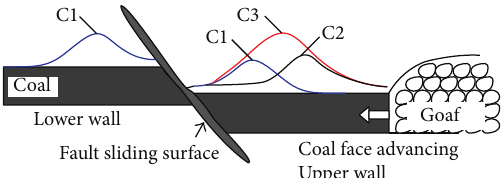
Figure 2: The cross section of a normal fault and abutment distribution: C1 is the preexisting tectonic pressure curve; C2 is the mining abutment pressure curve; and C3 is the superimposed pressure